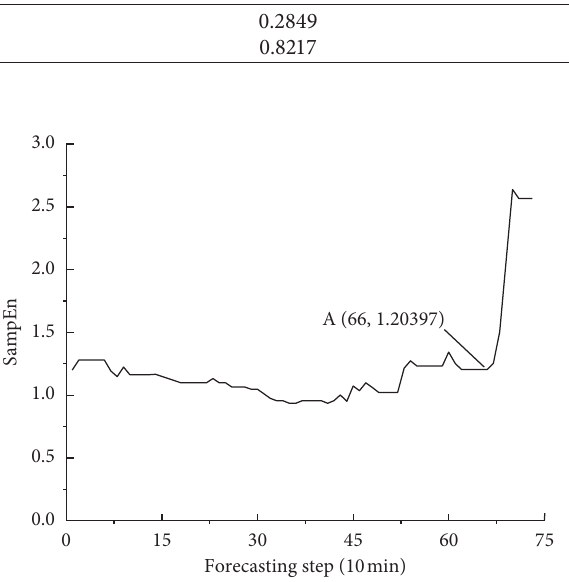
Figure 6: Rolling calculation of wind speed sample